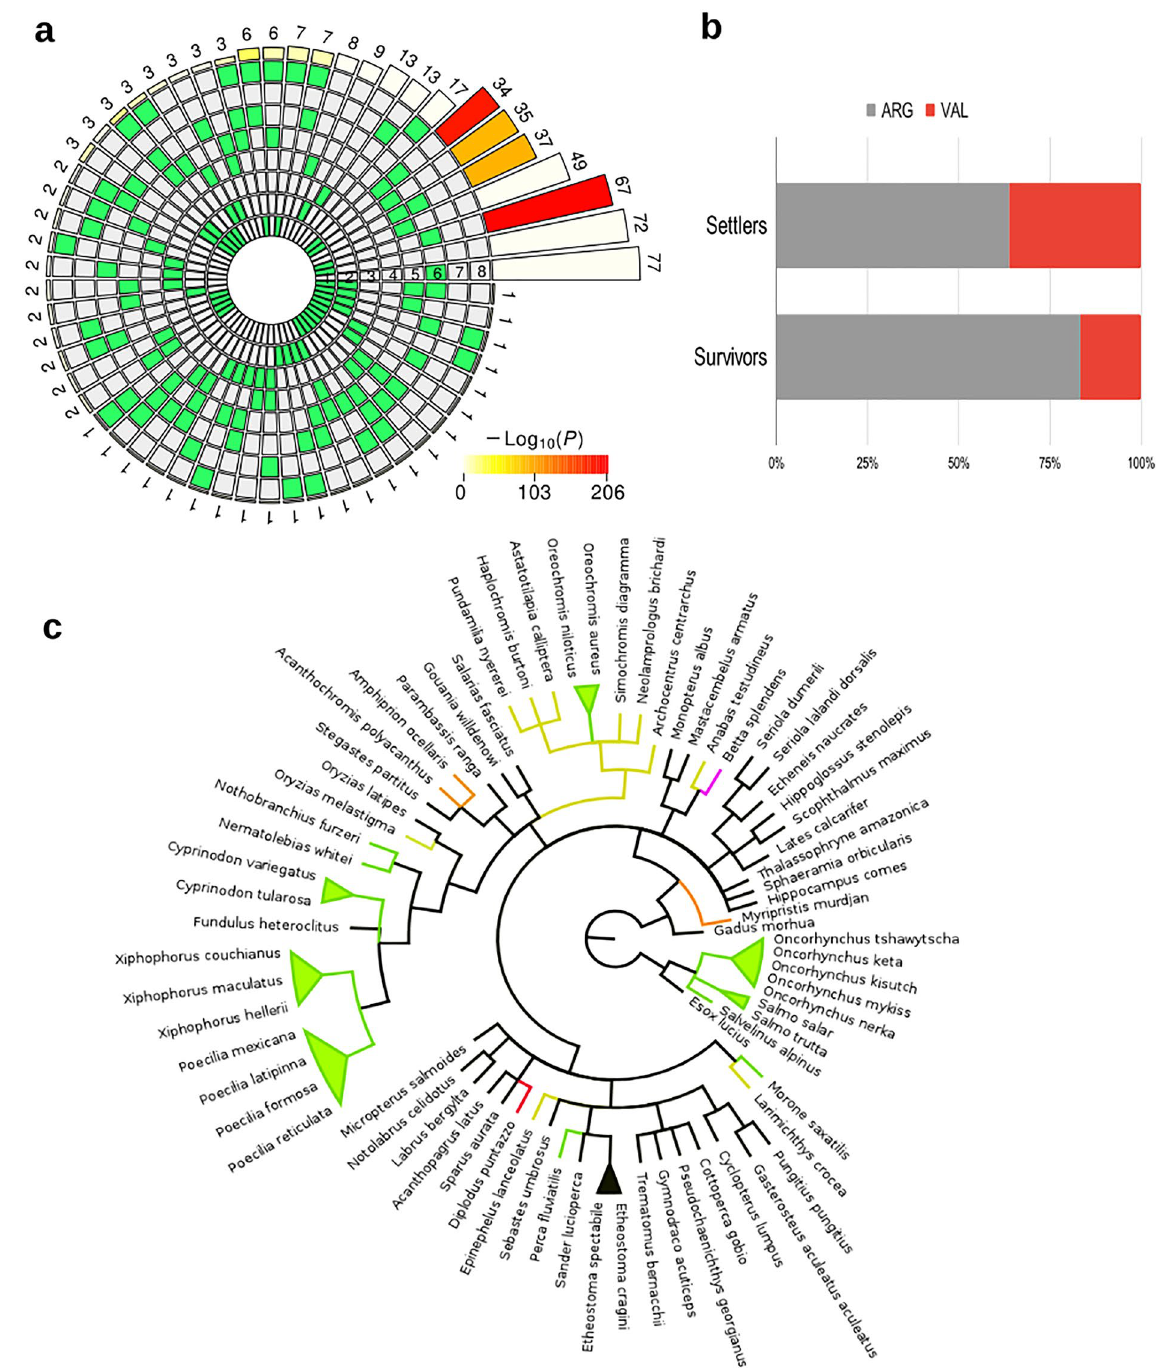
Figure 4. Environmental and phenotypic associations of the parallel set of loci. ( a ) Categorization of the loci with significant associations to phenotypic and environmental variables in the three populations. The variables are designated with numbers: 1: Hatch date, 2: Hatch size, 3: Moon hatch, 4: PLD, 5: GRPLD, 6: SST, 7: Settlement size, 8: Moon settlement. The eight inner circles indicate in green the presence of a significant association between each variable and the identified SNPs. The colour of the outer circle represents the P-value significance of the category, constituted by one or multiple associated variables, and the number of SNPs found in that category is given on top of each bar. ( b ) global amino-acid frequency in the three populations for settlers and survivors for the polymorphism found in the parallel locus mapping to the coding region of the Interleukin 20 Receptor Subunit Beta (Locus_94259) and associated with hatch date, SST and moon set. ( c ) neighbour-joining tree of 74 fish species. Labels are coloured according to the amino acid found in position 197, corresponding to the polymorphic allele represented in ( b